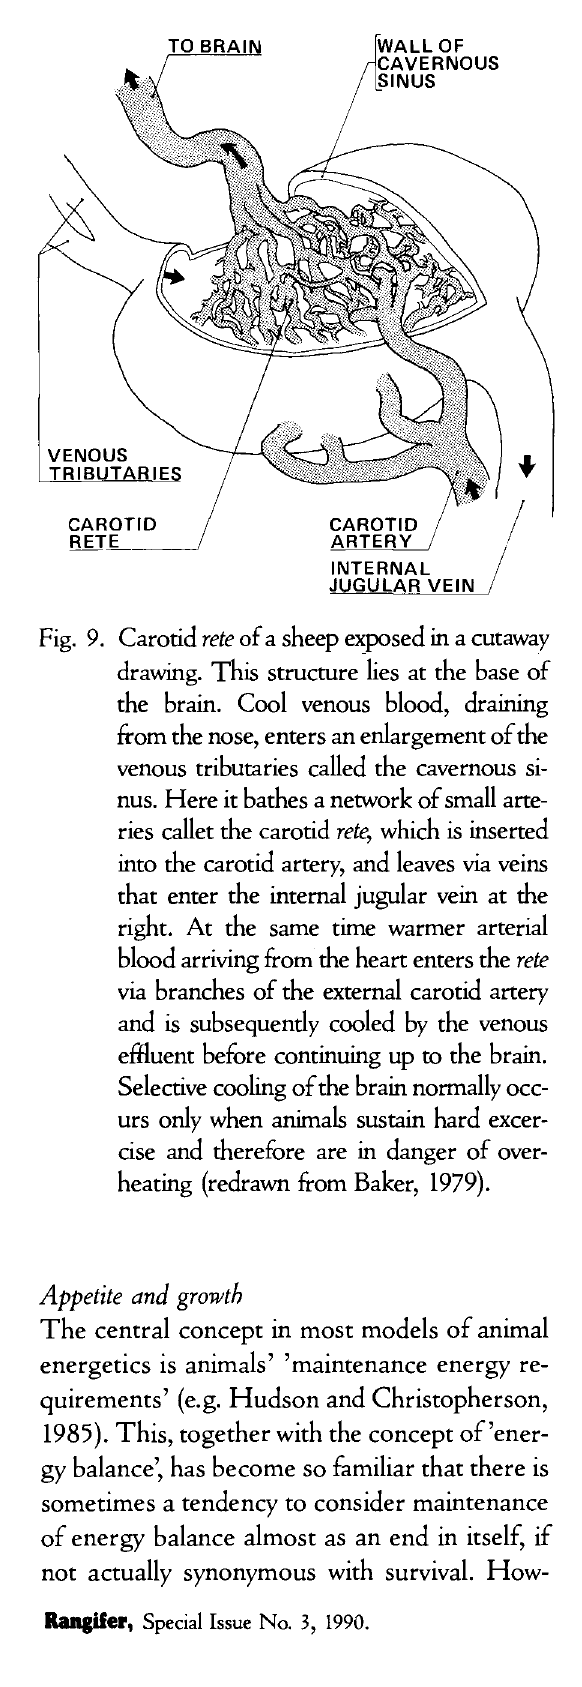
Fig. 9. Carotid rete of a sheep exposed in a cutaway drawing. This structure lies at the base of the brain. Cool venous blood, draining from the nose, enters an enlargement of the venous tributaries called the cavernous si nus. Here it bathes a network of small arte ries callet the carotid rete, which is inserted into the carotid artery, and leaves via veins that enter the internal jugular vein at the right. At the same time warmer arterial blood arriving from the heart enters the rete via branches of the external carotid artery and is subsequently cooled by the venous effluent before continuing up to the brain.